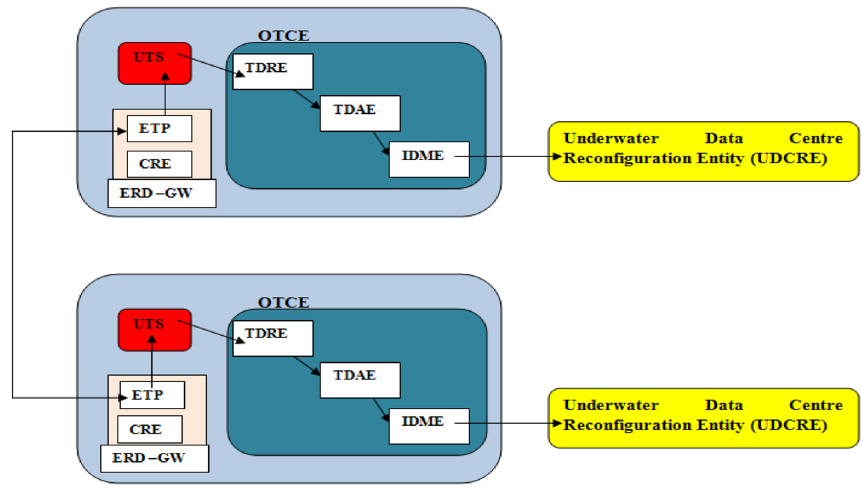
Figure 2. Relations between the ERD–GW and ETP for a case comprising two UDCs.